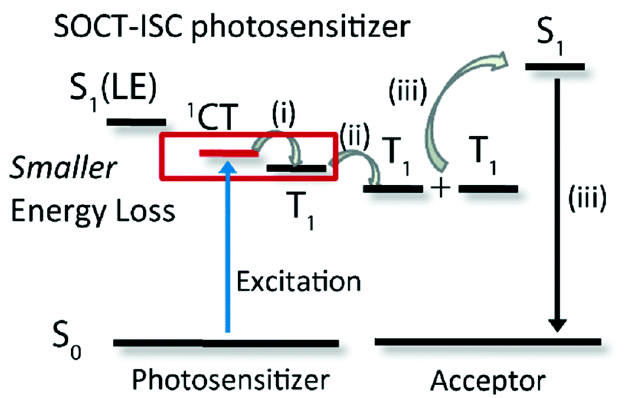
Figure 8. Simplified energy diagram showing the advantage of the creation of CT absorption band in electron donor-acceptor compounds: absorption wavelength is red-shifted, but the chromophore- localized triplet state does not decrease. (i) ISC (ii) TTET (iii) TTA and delayed fluorescence. Repro- duced with permission from reference [54], copyright 2019, Royal Society Chemistry.